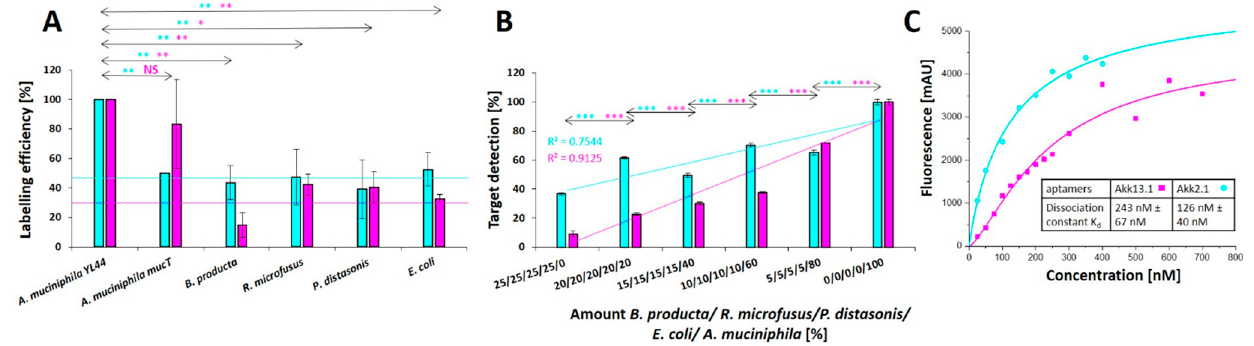
Figure 4. The aptamers Akk2.1 and Akk13.1 are highly potent in detecting A. muciniphila specifically. ( A ) Increased specificity of the aptamer Akk2.1 and Akk13.1 toward A. muciniphila compared to the microbiome control organism. The labeling background for Akk2.1 (cyan line) determined from the average fluorescence of the control organism is higher with 45% as the labeling background of Akk13.1 with 32% (magenta line) ( B ) Recovery of A. muciniphila from mixtures with microbiome associated organisms using the Akk2.1 and Akk13.1 aptamers. With an increasing amount of A. muciniphila , a higher fluorescent signal was detected, demonstrating the ability to detect of Akkermansia colocalized with other organisms. Statistical analysis by a t test was performed for the specificity of the individual aptamers and the detection of A. muciniphila in complex mixtures. p values < 0.05 were considered significant. * denotes p < 0.05, ** p < 0.01 and *** p < 0.001 ( C ) A. muciniphila incubated with different concentrations of the Akk2.1 and Akk13.1 aptamer to determine the dissociation constant. From the increasing fluorescent signal a dissociation constant of 126 nM for AKK2.1 and of 243 nM for AKK13.1 was determined.